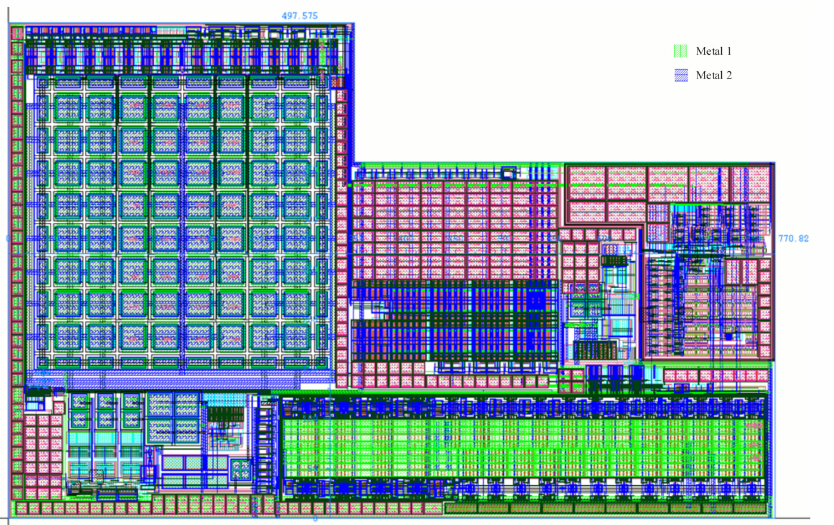
Figure 6. The overall layout design of the system.